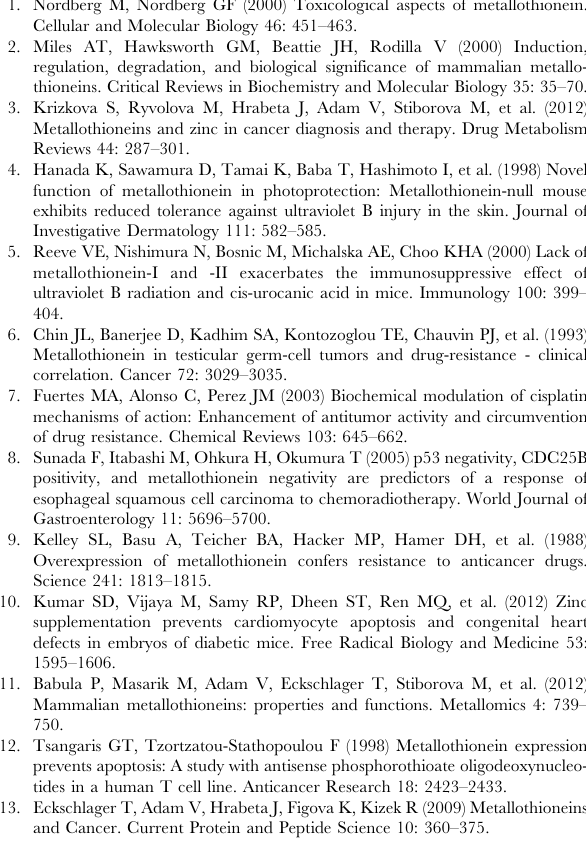
Figure S1 Prisma 2009 flow diagram showing the number of citations retrieved by database